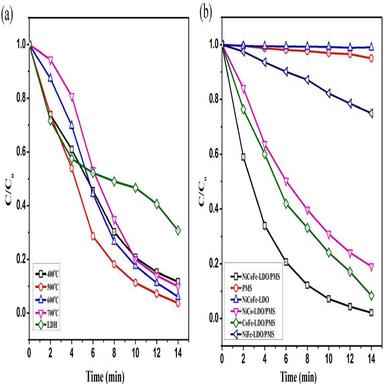
(a) RhB treatment efficiency of NiCoFe-LDO annealed at different temperatures and (b) RhB treatment efficiency of different reaction systems. (Condition: 20 mgRhB/L, 500 mgPMS/L, 60 mgLDO/L, pH 7.0, 25 ◦C).